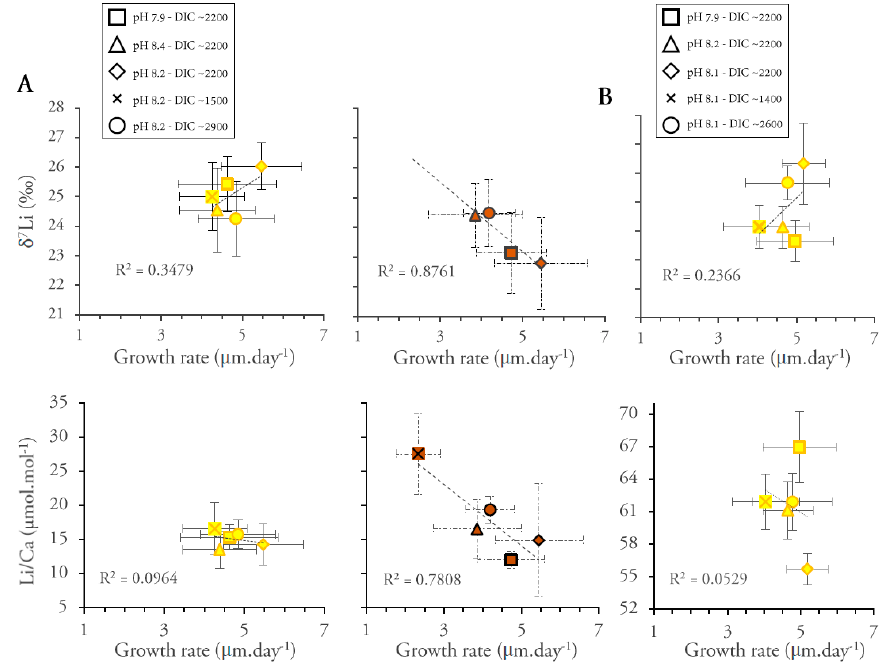
Figure 4. δ 7 Li values and Li/Ca ratios as a function of Amphistegina lessonii growth rates. ( A ) Normal seawater and ( B ) ×5 Li-enriched seawater. Yellow symbols—light/dark cycles. Brown symbols— dark only. Note the different vertical scales for Li/Ca between panels. The error bars represent the external error (2 σ ).